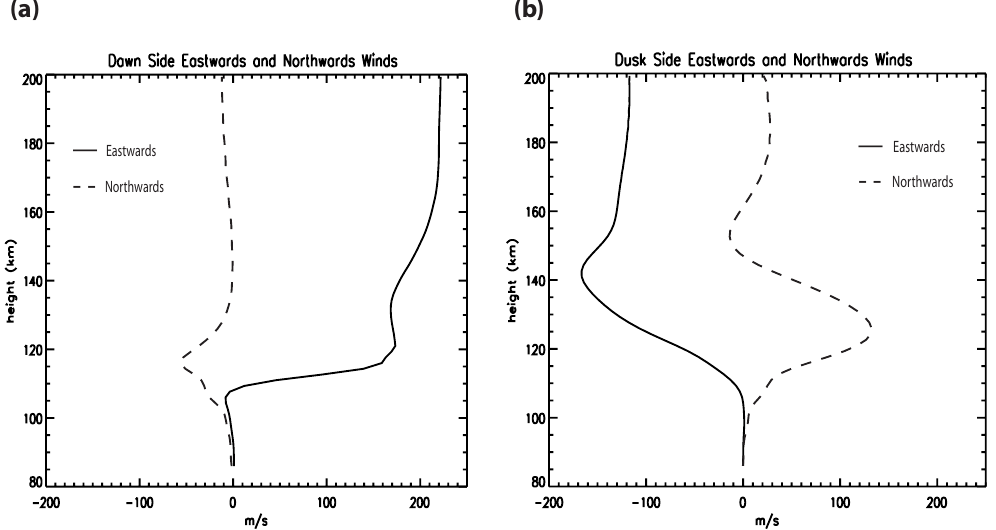
Fig. 2. Profiles of the simulated eastwards and northwards winds versus height, plotted at the center of the latitudinal and longitudinal domains, for equivalent conditions on the dawn and dusk sides (a) dawn side (b) dusk